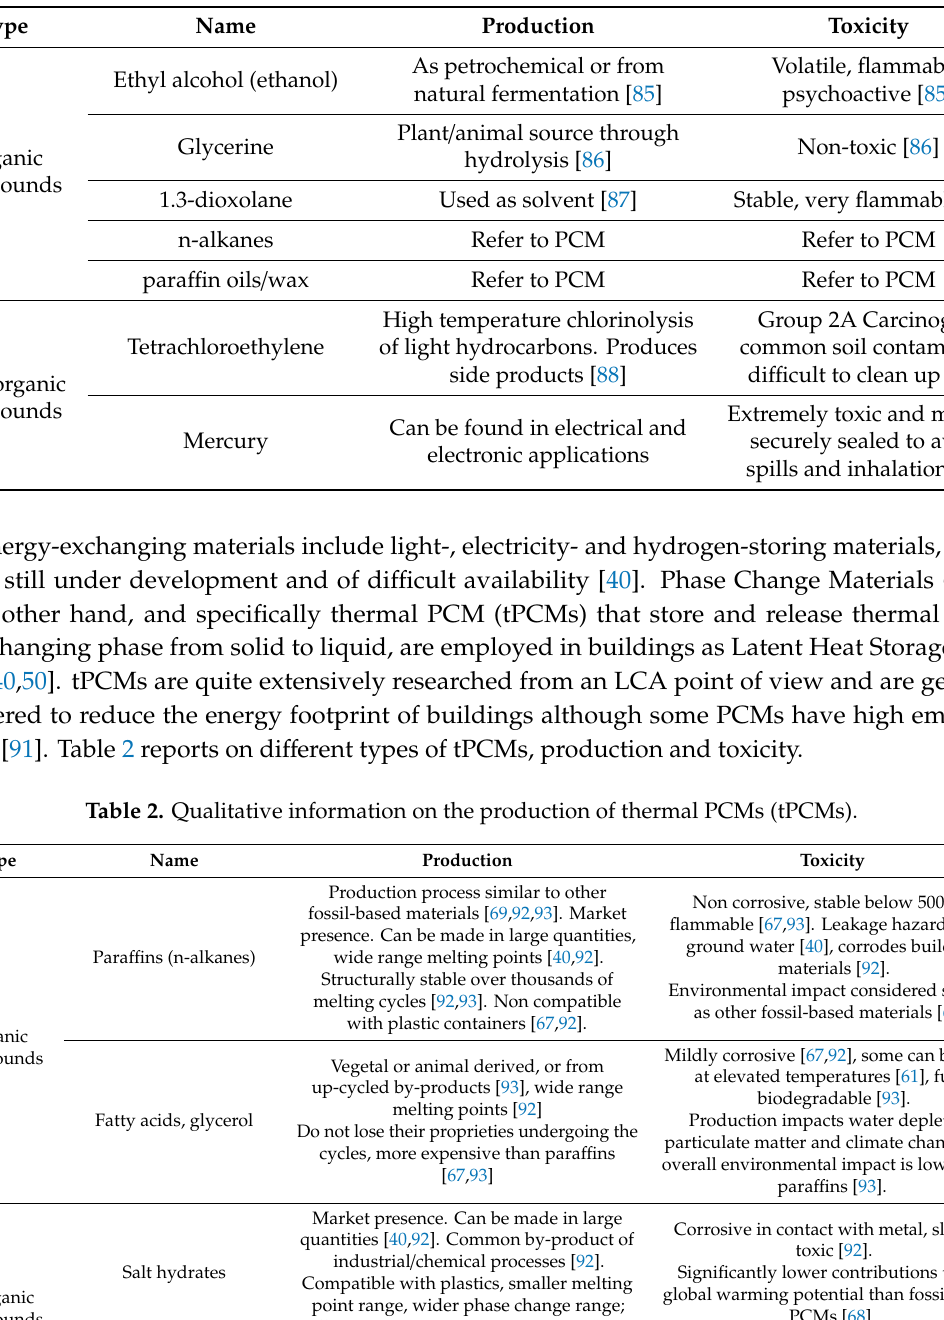
Table 1. Qualitative information on the production of Thermal Expansion Materials (TEMs).